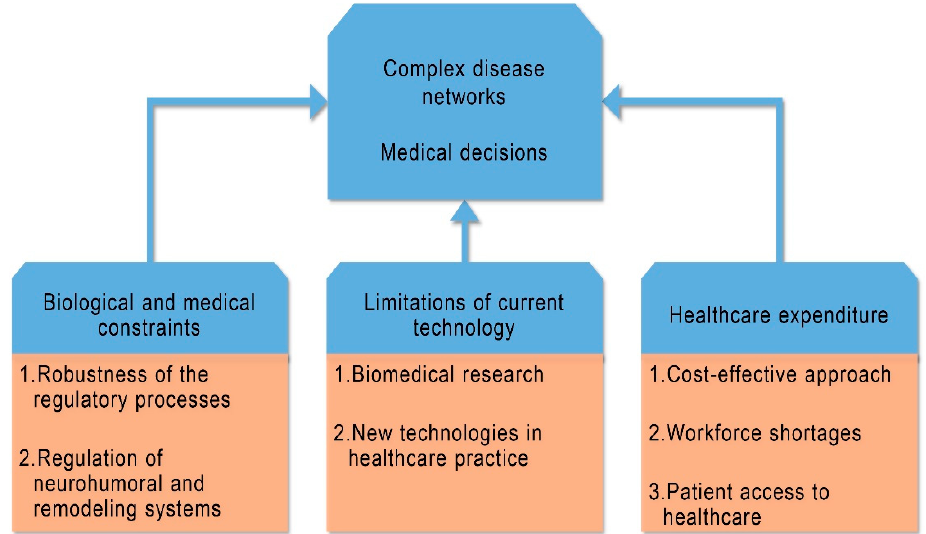
Figure 5. Constraints in three fields related to clinical cardiology; they behave as regulatory mechanisms for complex disease networks and medical decisions.